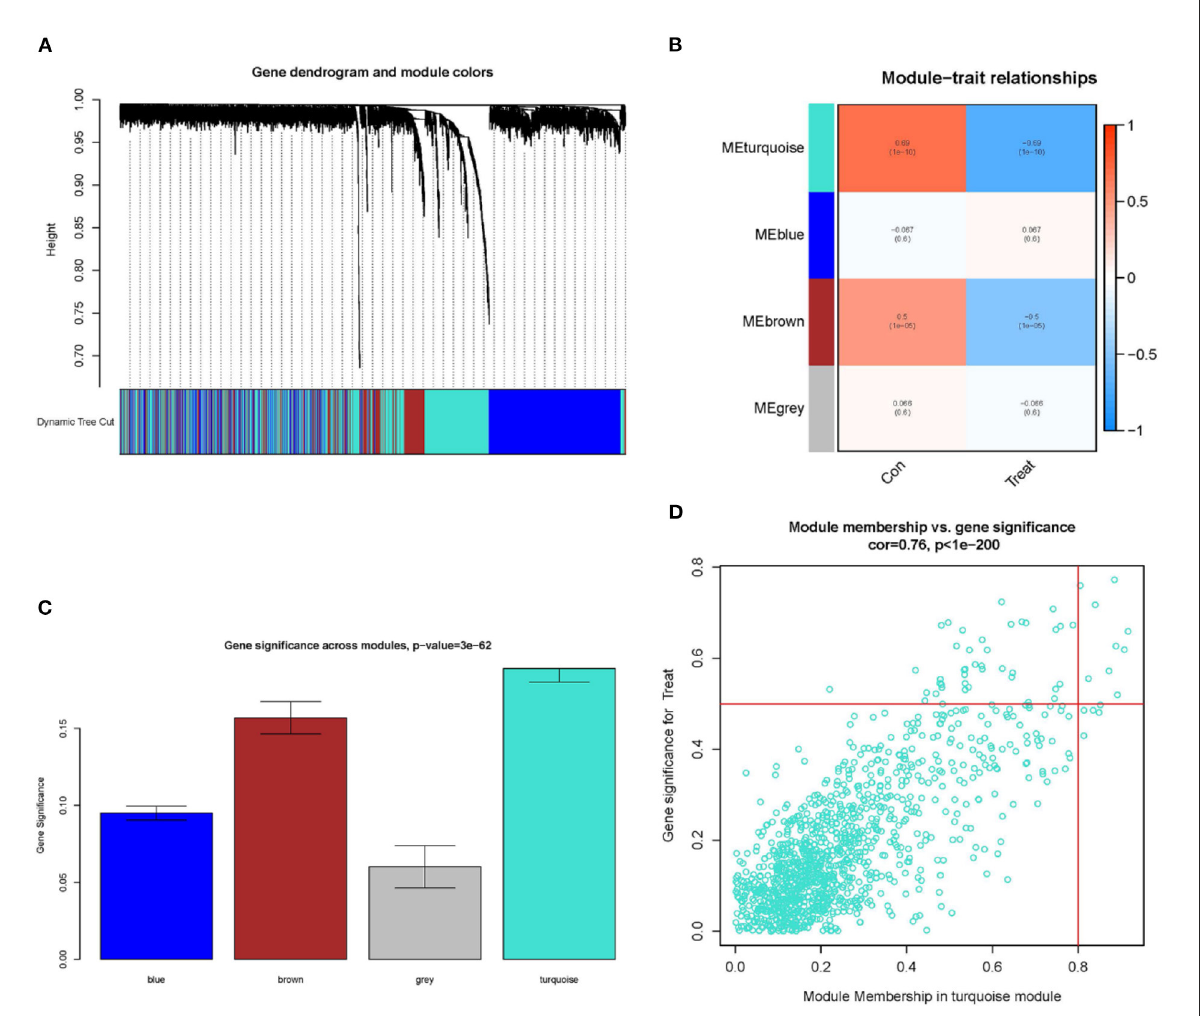
FIGURE2 Constructing WGCNA modules and screening candidate key genes. (A) Gene clustering dendrogram: each branch represents a gene, and each color below represents a co-expression module. (B) Module-trait relationships heatmap, with turquoise modules significantly associated with controls. (C) Distributing gene significance in each module. (D) In the turquoise module, a scatter plot of gene module members vs. gene significance is shown, GS > 0.5 and MM > 0.8 are candidate key